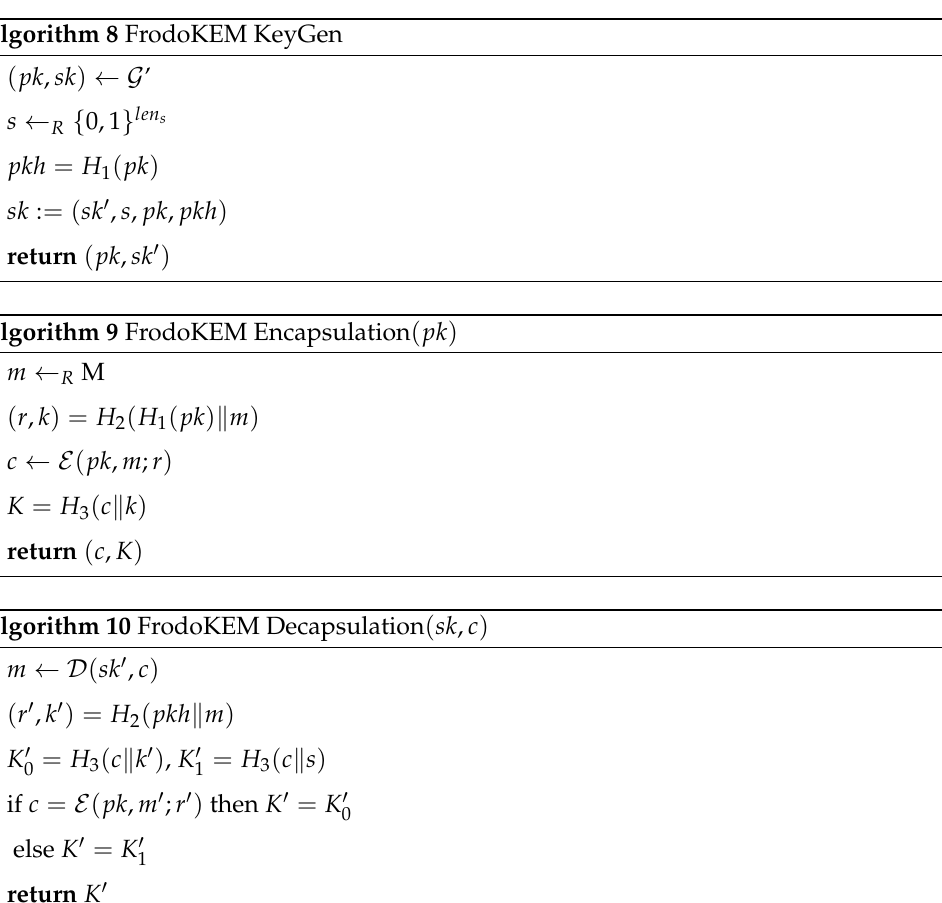
Algorithm 8 FrodoKEM KeyGen